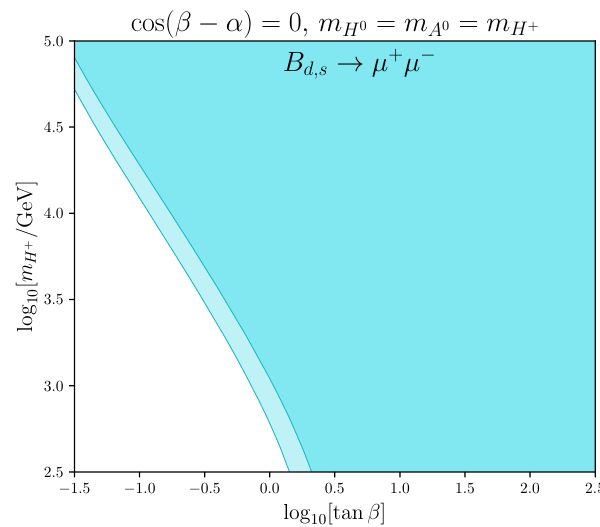
Figure 6 . Contour plot of the allowed 2HDM-I parameter space in the ( tan β − m for the combined fit to ( B d,s → µ + µ − ) , taken in the limits of alignment ( cos( β − α ) = 0 ) and degenerate masses ( m = m = m ). The darker contour indicates allowed parameter space H 0 A 0 H + at 1 σ confidence, and the lighter at 2 σ